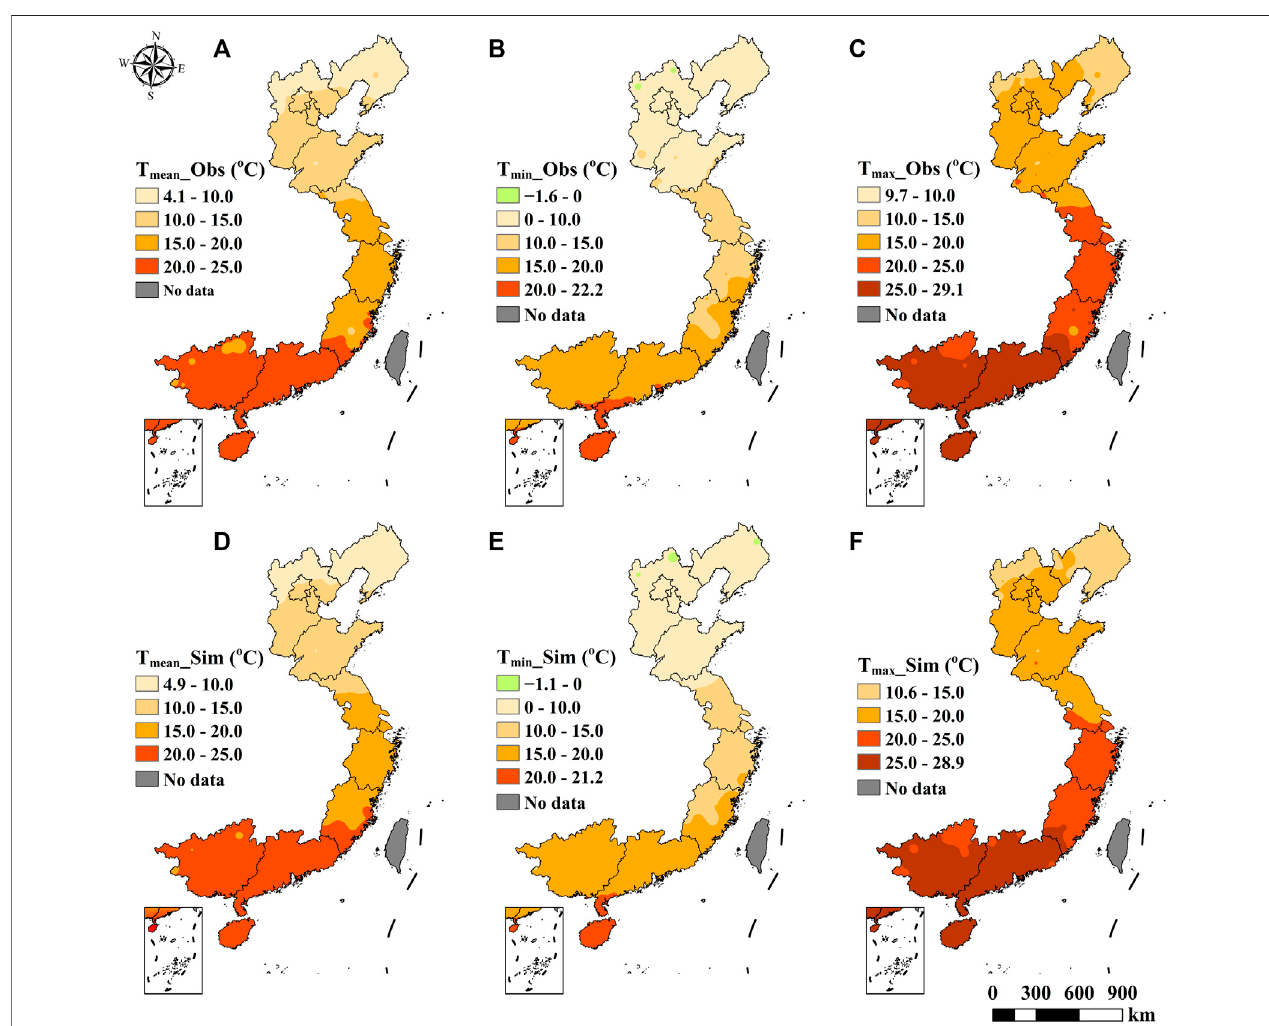
FIGURE 3 | Spatial distribution of multi-year average for observed Tmean (A) , Tmin (B) , Tmax (C) and projected Tmean (D) , Tmin (E) , Tmax (F) by SimCLIM over CAC during 1996-2018.